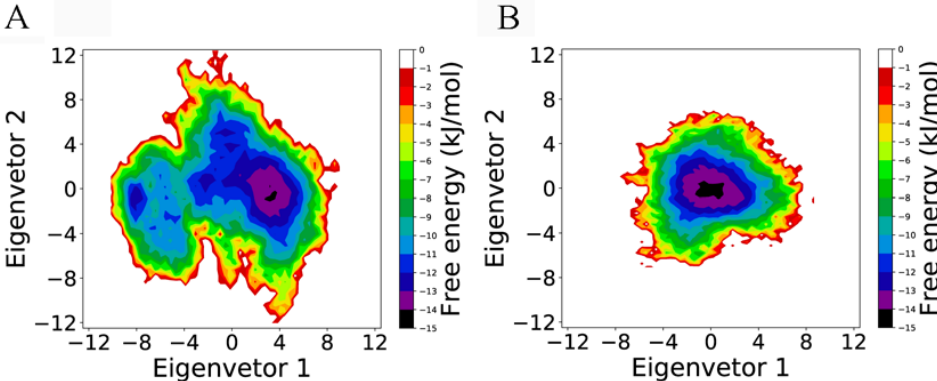
Figure 3. Free energy landscapes (FELs) of the two complexes as a function of the projection of the single joined equilibrium trajectory onto the essential subspace spanned by eigenvectors 1 and 2. ( A ) FEL of the RBD CoV -ACE2 complex. ( B ) FEL of the RBD CoV2 -ACE2 complex. The color bar represents the relative free energy value in kJ/mol.